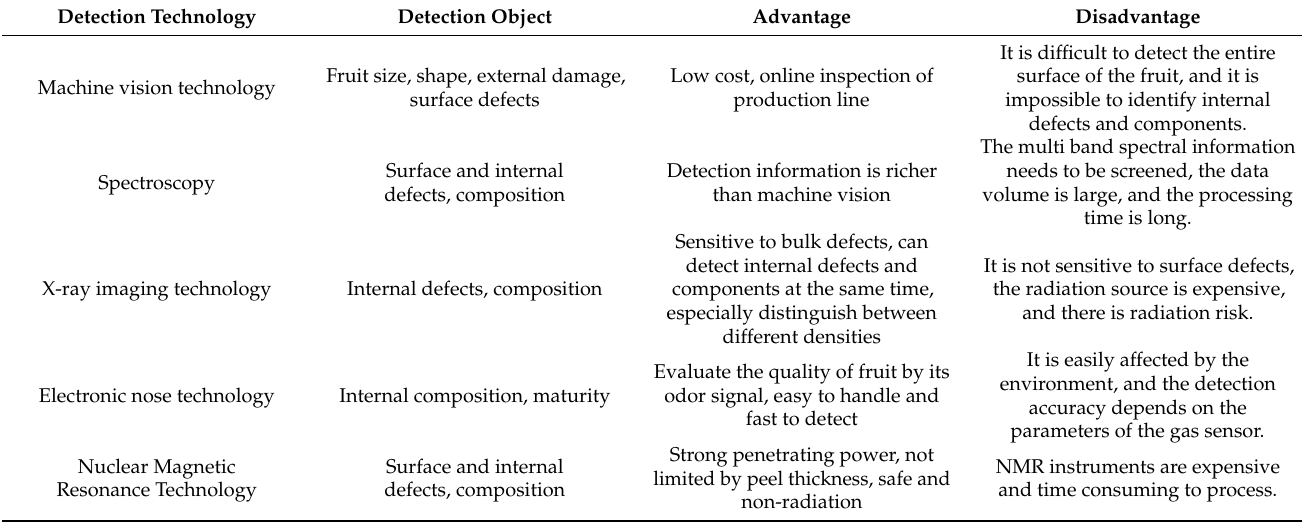
Table 1. Comparison of fruit quality detection